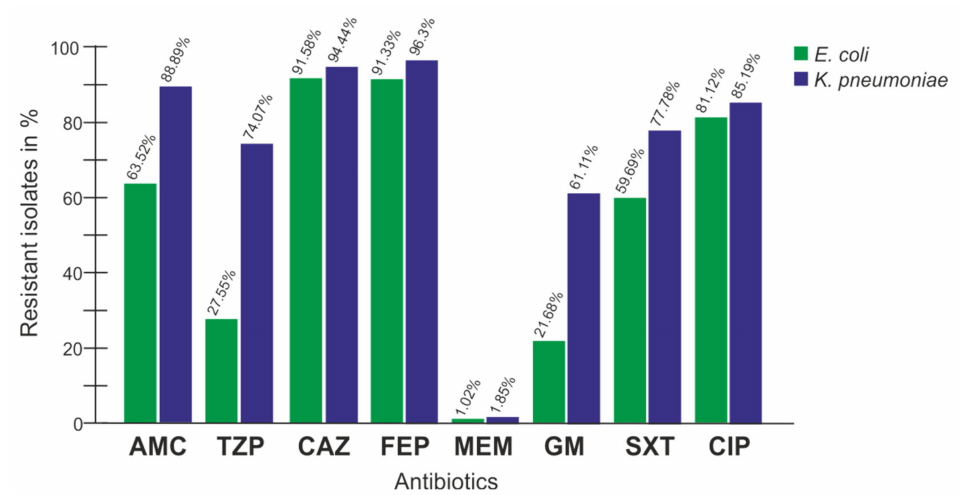
Figure 1. Resistance profile comparison of E. coli (n = 392) and K. pneumoniae (n = 54). AMC: amoxicillin/clavulanic acid; TZP: piperacillin/tazobactam; CAZ: ceftazidime; FEP: cefepime; MEM: meropenem; GM: gentamicin; SXT: trimethoprim/sulfamethoxazole; CIP: ciprofloxacin. A total of 399 ESBL genes and 148 non-ESBL variants ( bla TEM-1 , bla SHV-1 , bla SHV-11 ; Table S1) were detected in the 392 E. coli isolates. The most abundant ESBL genes for E. coli were members of the bla CTX-M-1 group (n = 288, 72.18%) (Figure 2). From the 54 K. pneumoniae isolates, 59 ESBL genes, and additionally, 87 non-ESBL variants ( bla TEM-1 , bla SHV-1 , bla SHV-11 , bla SHV-28 , and bla SHV-76 ; Table S1) were detected. Forty-eight (81.36%) of the 59 ESBL genes belonged to the bla CTX-M-1 group . Not surprisingly, bla CTX-M-15 (a member of the CTX-M-1 group of genes) was proportionately most common in both species with 61.15% (n = 244) of the ESBL positive E. coli and 72.88% (n = 43) of the ESBL positive K. pneumoniae . ESBL bla SHV gene variants were more abundant in the K. pneumoniae isolates (11.86%) than in the E. coli isolates (1.75%). For the bla CTX-M-9 group , the proportional abundance was higher in E. coli (26.07%) than in K. pneumoniae